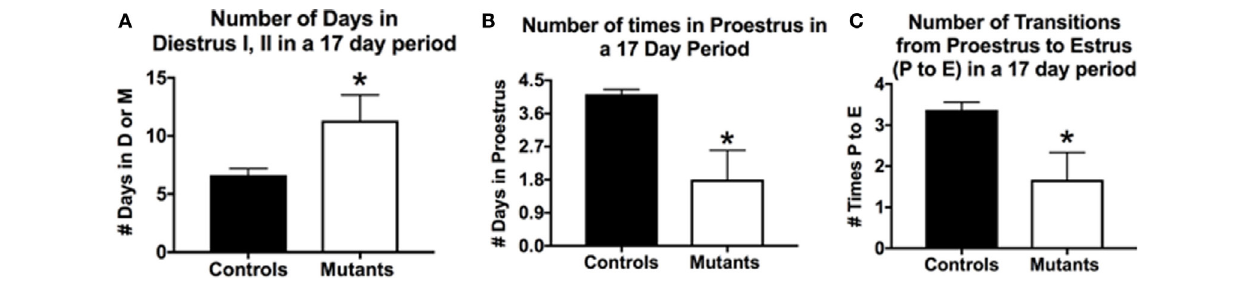
FiGUre 1 | Deletion of Lepr exon 1 in gonadotropes leads to severe reproductive deficiencies. Deletion mutant mice bearing two floxed alleles of Lepr ( Lepr-exon 1 loxP/loxP obtained from Dr. Jeffery Friedman) were bred to female mice bearing the Cre-recombinase gene driven by the bLh- β promoter ( bLh β - cre ) developed by Dr. Sally Camper (108). The Cre-recombinase was passed through the female line, because it was reported to be expressed in the testes (108), and all breeding was tested only in females. The resulting offspring carried two floxed Lepr alleles and were either positive (one allele) or negative for Cre-recombinase in gonadotropes. Breeding studies done as described previously (33) produced seven female homozygous mutants that were evaluated for cyclicity over a 17-day period. (a) On average, females spent more days in diestrus I (metestrus) or II in the 17-day period days (compared with control females). (B) Mutants spent fewer days in proestrus and (C) In the 17-day test period, there were only 1.6 proestrous to estrus transitions in the mutants. Stars over mutant bars indicate significantly different values as compared to controls by the Student’s t -test.